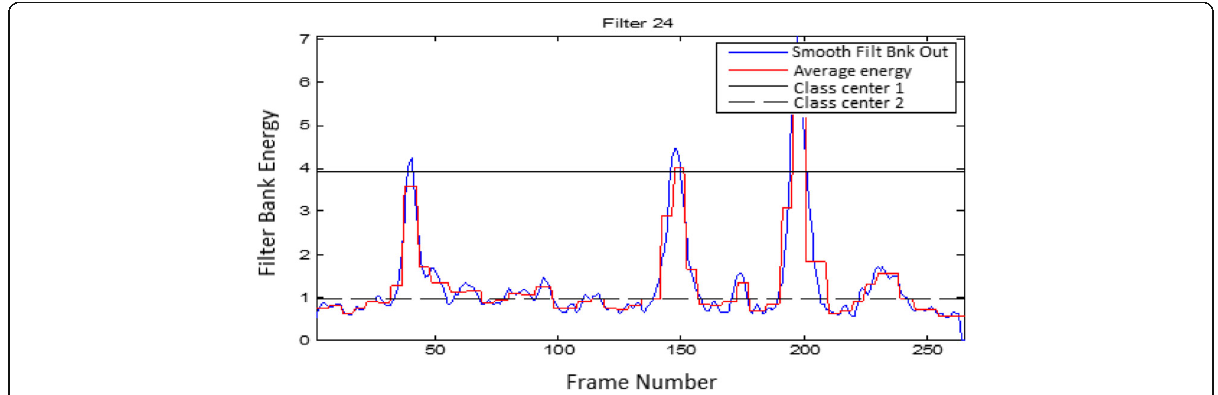
Fig. 3 Results of the regression and the k-means in filter